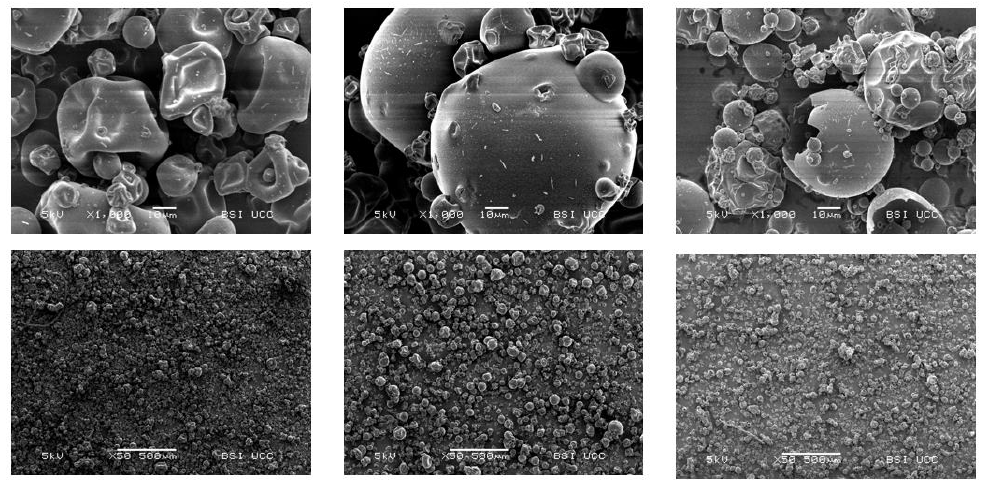
Figure 7. SEM images of PPI ( left ), SPI ( middle ), and EverPro ( right ) at ×1000 (top row) and ×50 ( bottom row) magnification.